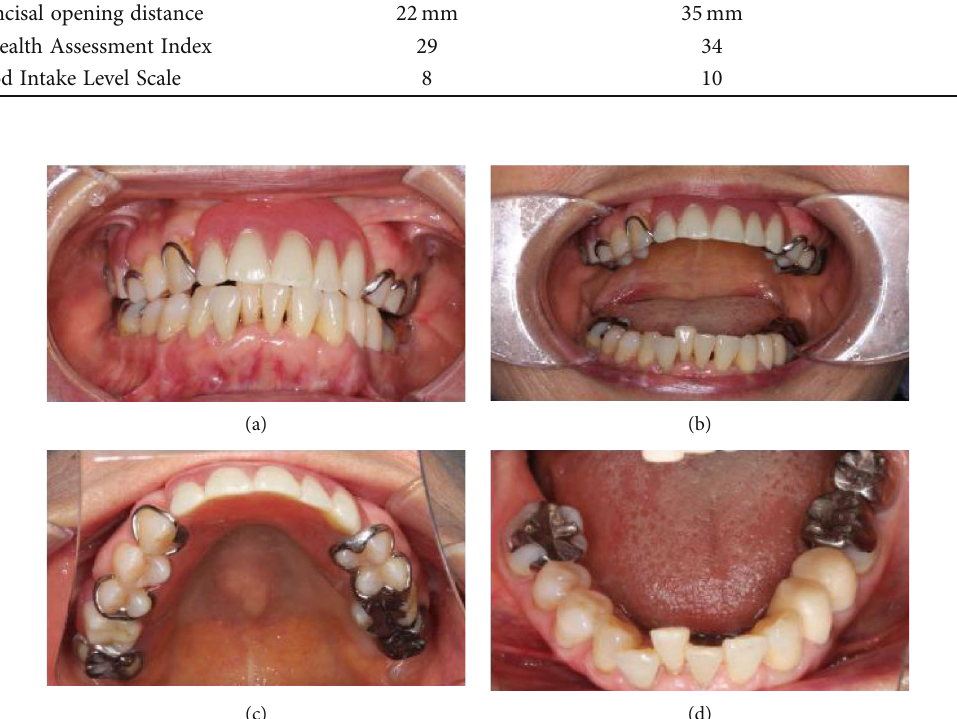
Figure 6: Postoperative views: (a) front view, (b) maximum mandibular opening at postoperation, (c) occlusal view of maxilla, and (d) occlusal view of